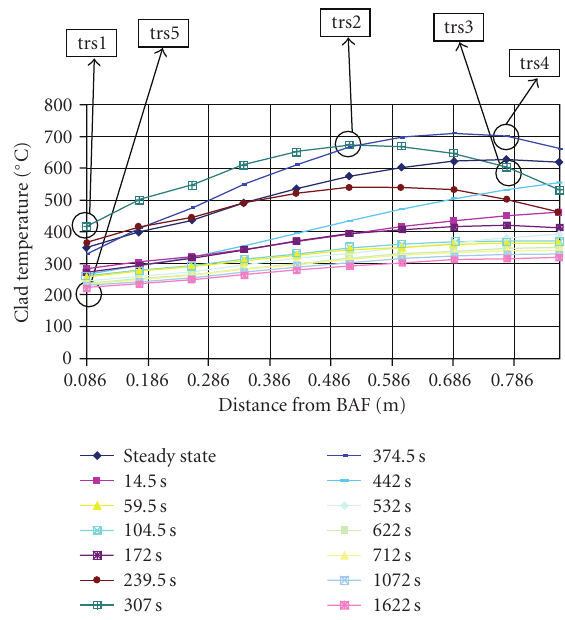
Figure 13: Temperature axial profile (LOFA—Average Channel) with the points selected for the CFD simulations identified.